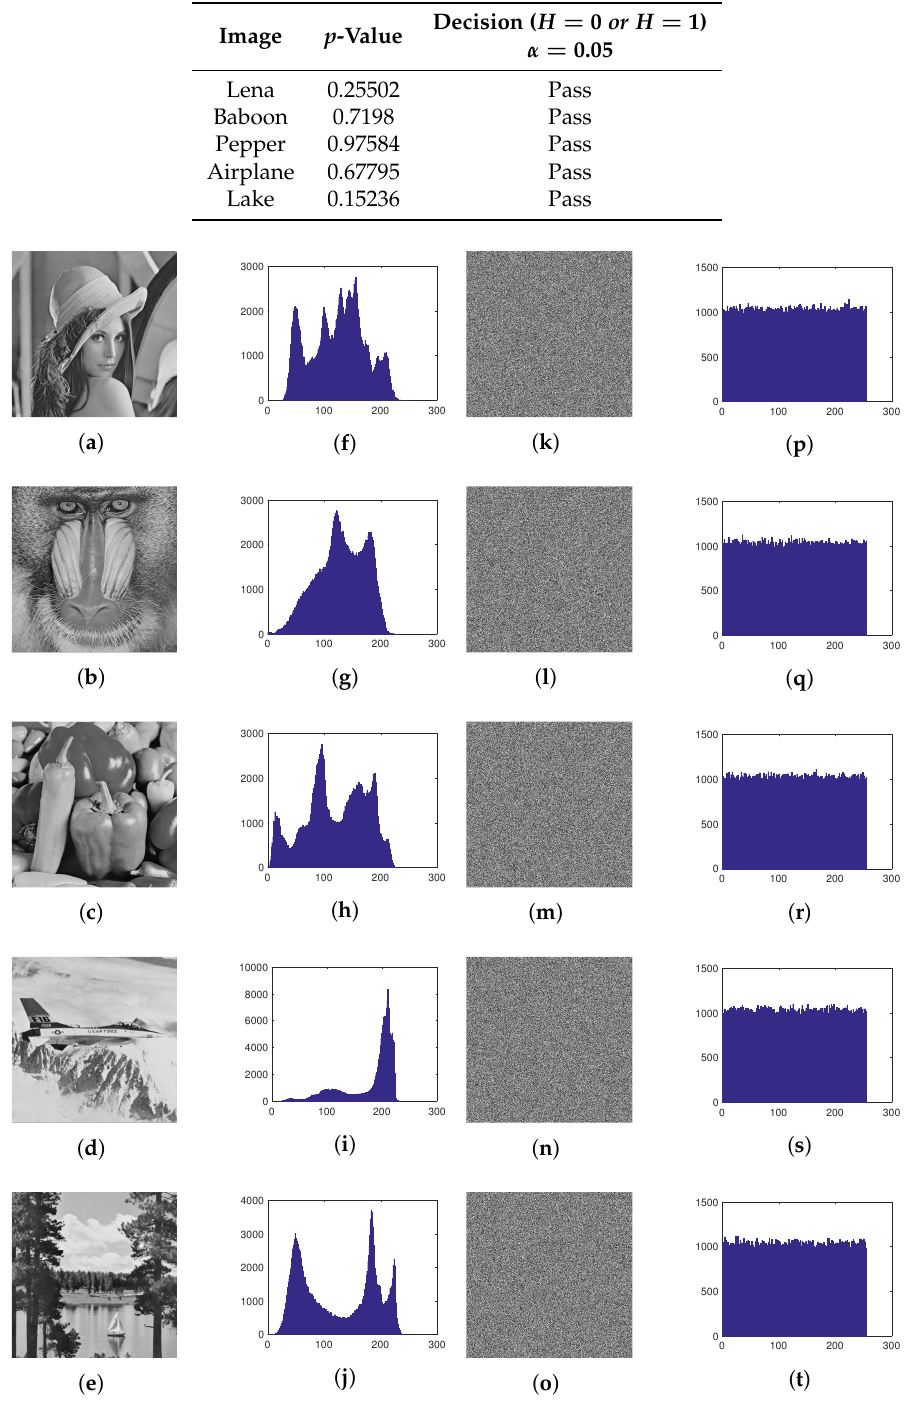
Figure 5. Histograms. ( a – e ) The plain images of ‘Lena’, ‘Baboon’, ‘Pepper’, ‘Airplane’ and ‘Lake’; ( f – j ) the corresponding histograms of these plain images; ( k – o ) the corresponding cipher images by encryption; ( p – t ) the corresponding histograms of these cipher